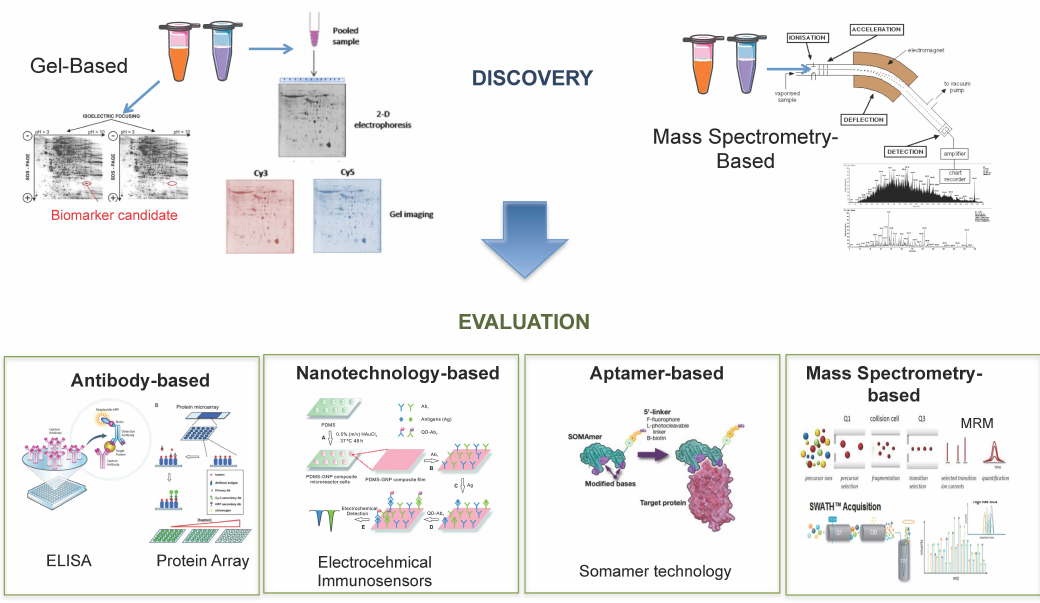
Figure 4. Proteomic Technology for Discovery and Evaluation of Protein Biomarkers.